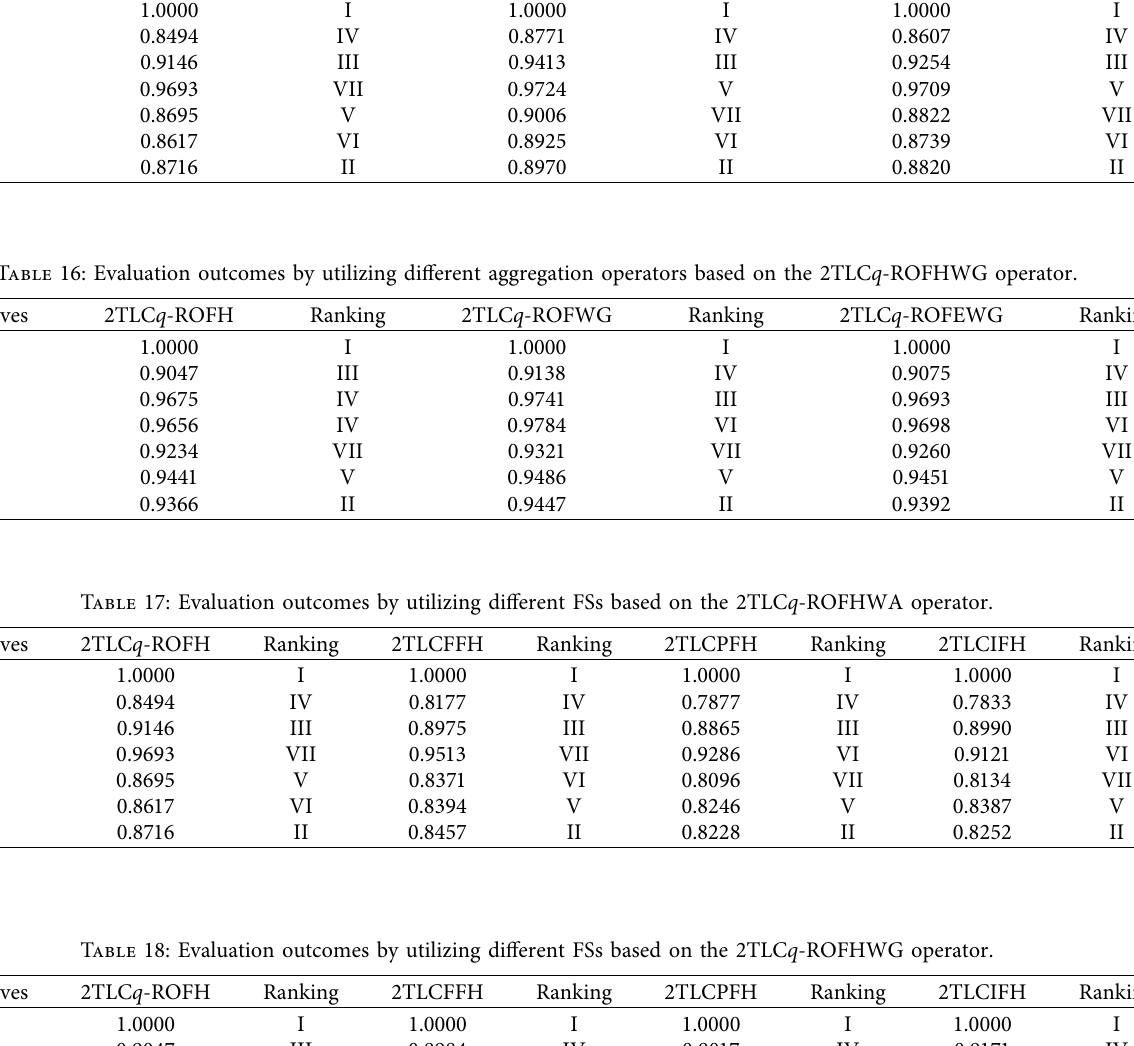
Table 15: Evaluation outcomes by utilizing different aggregation operators based on the 2TLC q -ROFHWA operator. Alternatives 2TLC q -ROFH